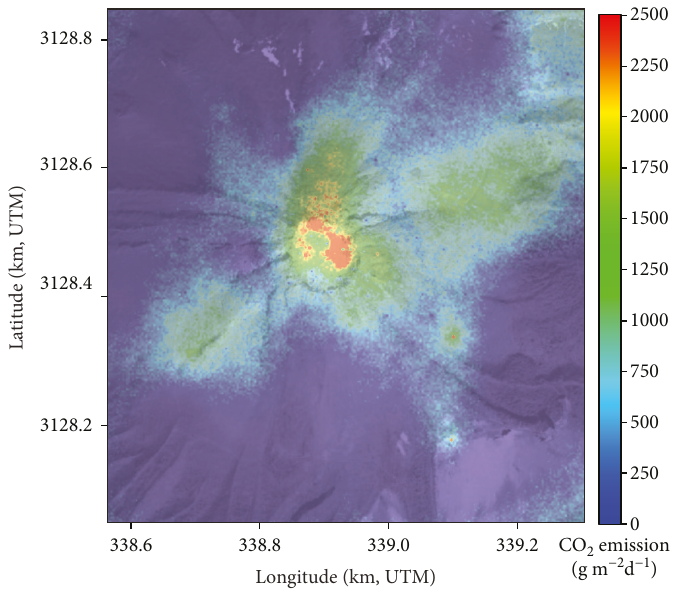
Figure 3: Di ff use CO emission map of the summit cone and crater of Teide 2